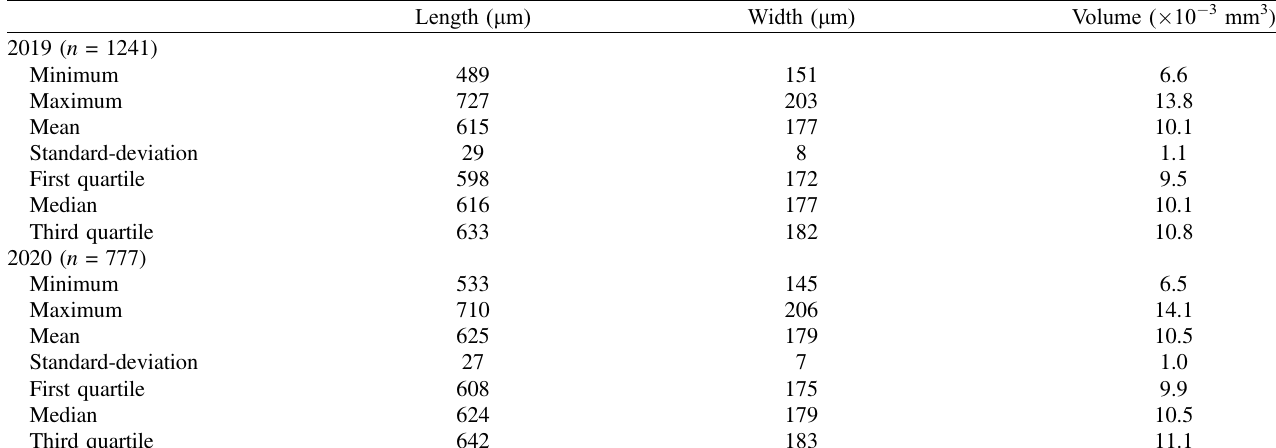
Table 2. Details of morphological metrics measured on Ae. japonicus eggs. Data originate from the Reichstett fi eld area. Length and width of eggs are measured three times per